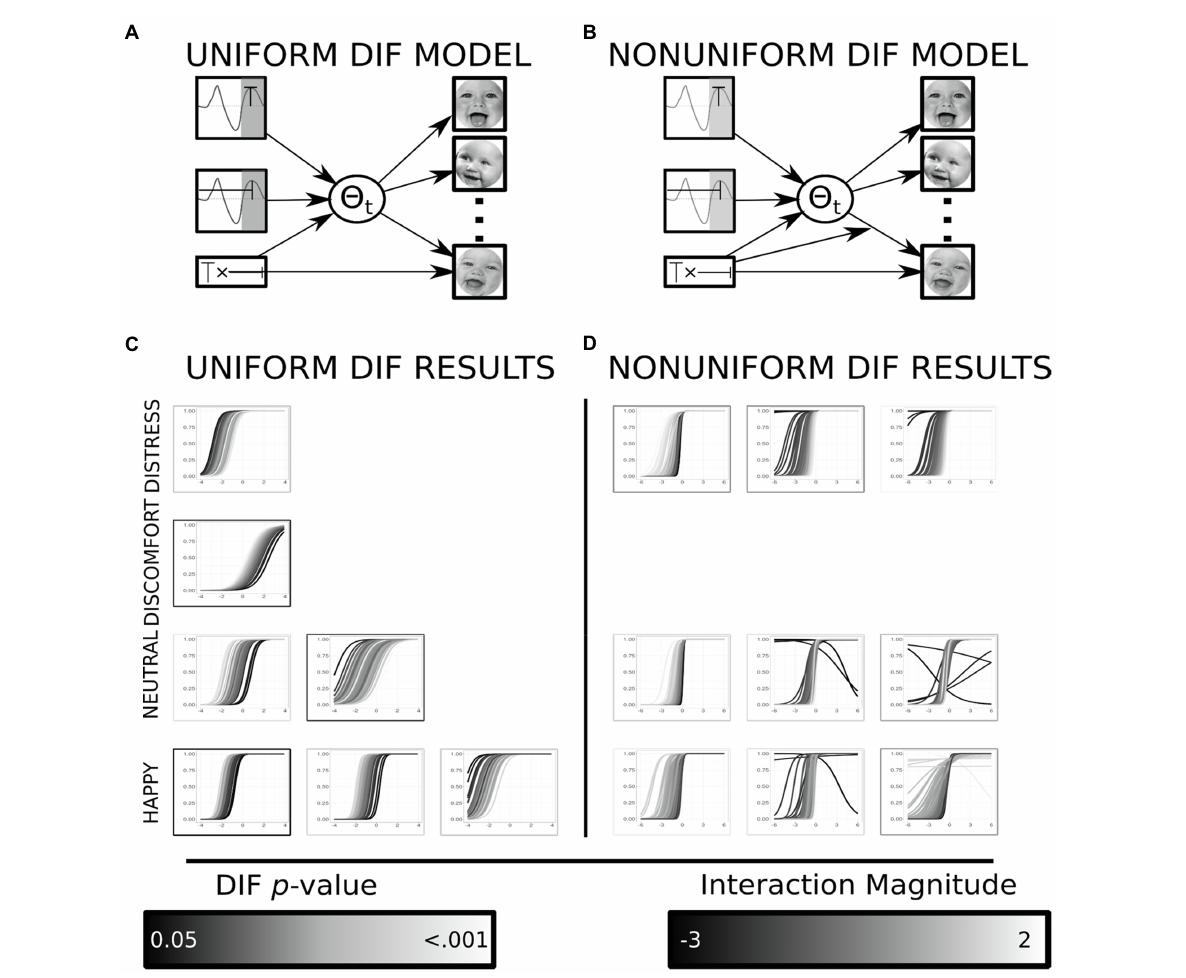
FIGURE 4 Results from DIF analyses. (A) Displays the mediation model used to identify all instances of uniform DIF within an emotion. (B) Displays the moderated mediation model used to identify all instances of nonuniform DIF within an emotion. (C) The resulting item characteristic curves (ICC) from all uniform DIF items organized within emotion. The color of the ICC is determined by the individual’s interaction (amplitude by latency) magnitude. The color of the border displays the significance of the direct path from the interaction to an item’s response patterns after controlling for the latent variable. The uniform DIF results in changes in difficulty (intercept) displayed by parallel shifts of the item characteristics curve. (D) The resulting ICC from all nonuniform DIF items organized within emotion. The color of the ICC is determined by the individual’s interaction (amplitude by latency) magnitude. The border displays the significance of the moderation between the individual’s interaction value and the latent trait onto an item’s response patterns after controlling for the latent variable. The nonuniform DIF analyses explore for changes in discrimination (slope), instances where item characteristics are not parallel indicate nonuniform DIF (Proverbio et al., 2006). Facial images reproduced with permission from Proverbio et al.